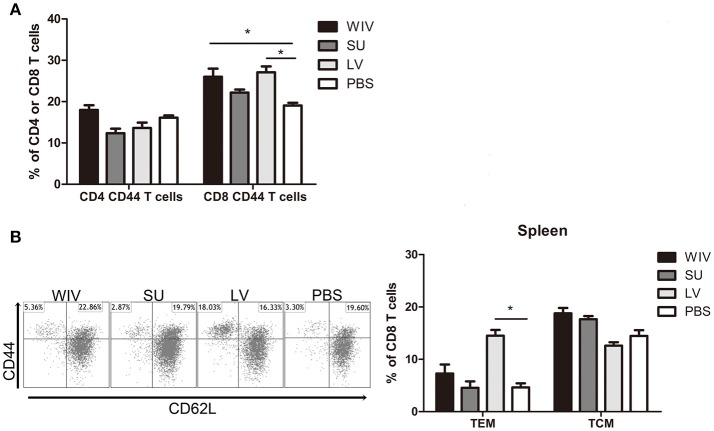
Memory T cell immune responses after sequential infection or immunization. Of the mice described in the legend to Figure 1, 5 animals/group were sacrificed 28 days after the second infection or immunization and spleen and lung were collected. (A) CD4+CD44+ and CD8+CD44+ memory T cells in spleen were determined by flow cytometry. (B) CD8+CD44+CD62L− effector memory T cells (TEM) and CD8+CD44+CD62L+ central memory T cells (TCM) in spleen. Left: representative dot plots depicting CD44 and CD62L expression on spleen CD8 T cells. Right: percentages of spleen CD8 TEM and TCM + SEM. (n = 4 or 5 per group, representative of two experiments, Mann-Whitney U-test, *p < 0.05).